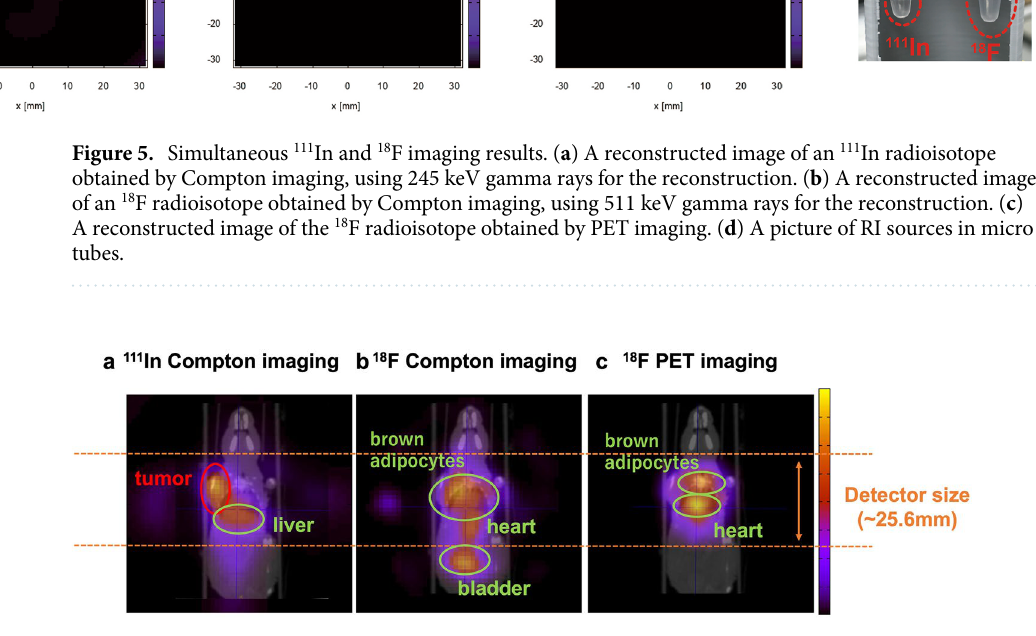
obtained using the 245 keV gamma rays (from 111 In) and 511 keV gamma rays (from 18 F), and Fig. 5c shows the PET imaging results. The location of each source appears clearly in these images. Although 18 F can be visualized with both Compton imaging and PET imaging, the shape of the 18 F source was more clearly visualized in the PET image than in the Compton image.